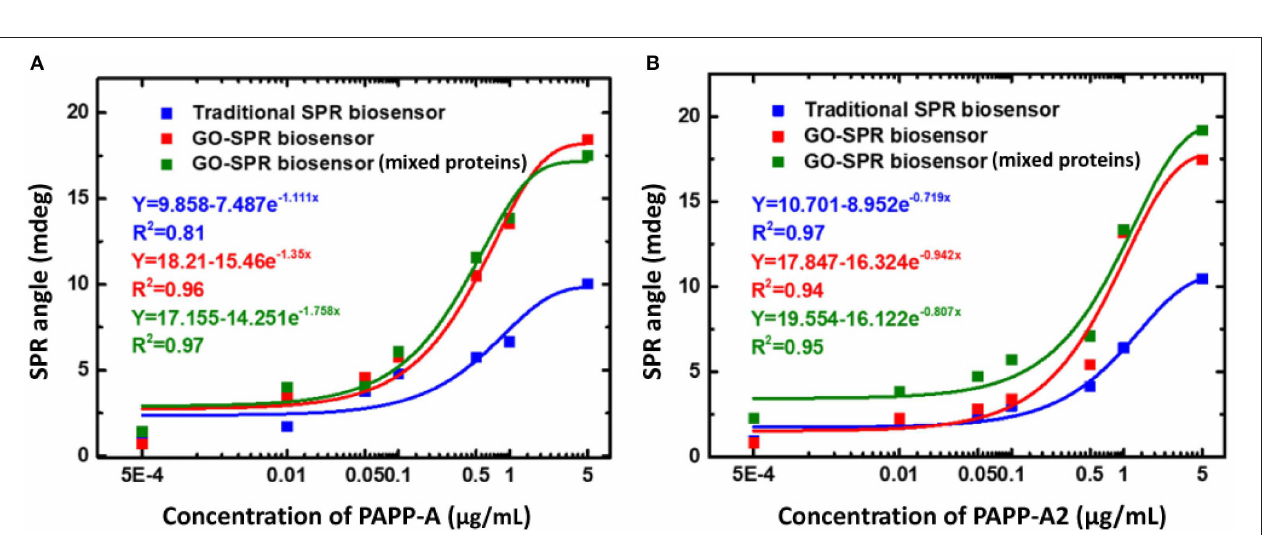
FIGURE 11 | Surface plasmon resonance response curves and curve fitting equations of PAPP-A (A) and PAPP-A2 (B) measurement with the traditional SPR biosensor and GO-SPR biosensor. Figures (A,B) were reproduced from Fan et al. (2020) with permission from Dove Medical Press.